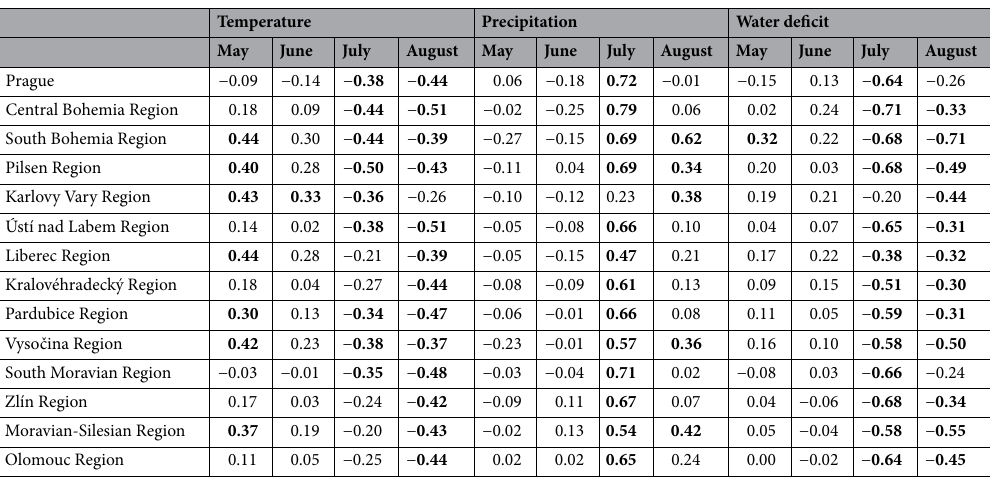
Table 2. Pearson correlation between grain maize yield rate with temperature, precipitation, and water deficit in all regions.